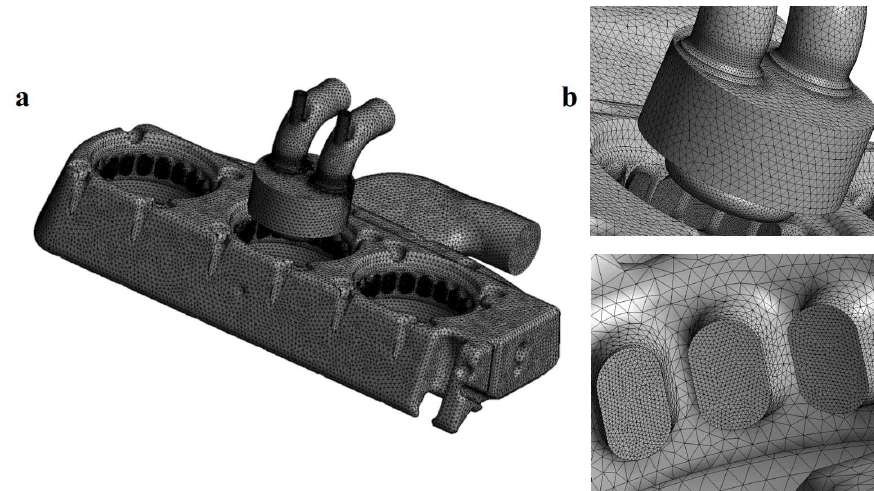
Figure 4. Computational domain. ( a ) Unstructured tetrahedral grid for plenum, intake manifold, Cylinder 3, and exhaust pipes. ( b ) Detailed views of Cylinder 3 and intake ports.